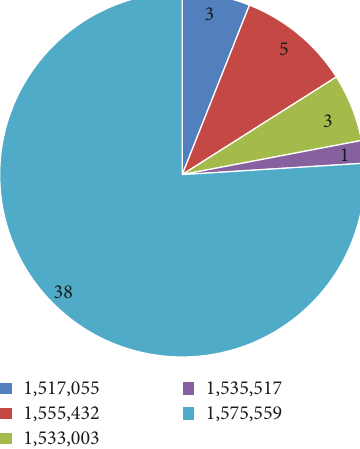
Figure 12: Ratios of the optimization results in the 50 fuzzy